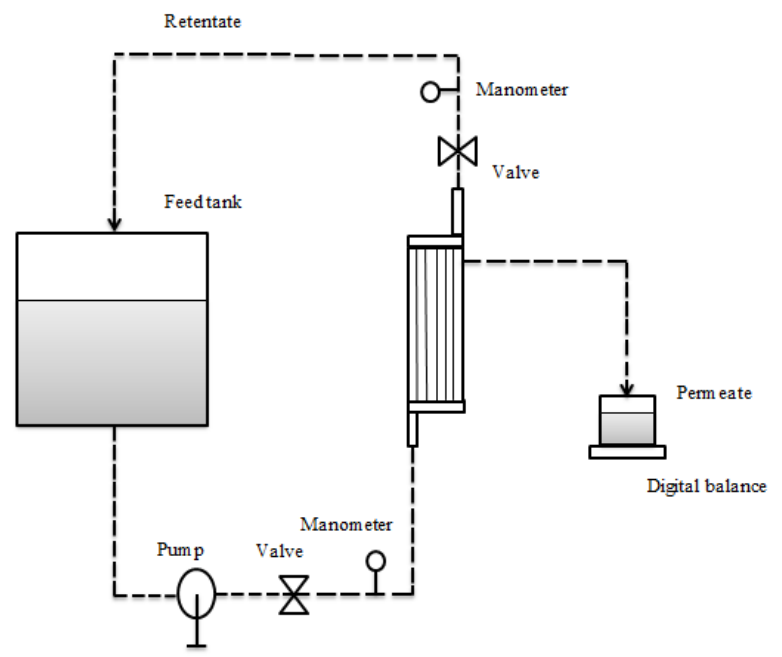
Figure 1. Schematic representation of the microfiltration process .